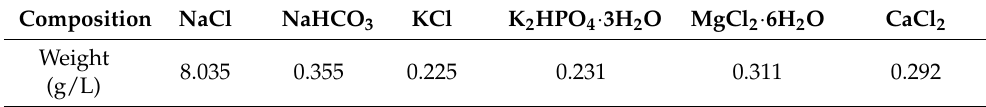
Table 1. Chemical composition of SBF.